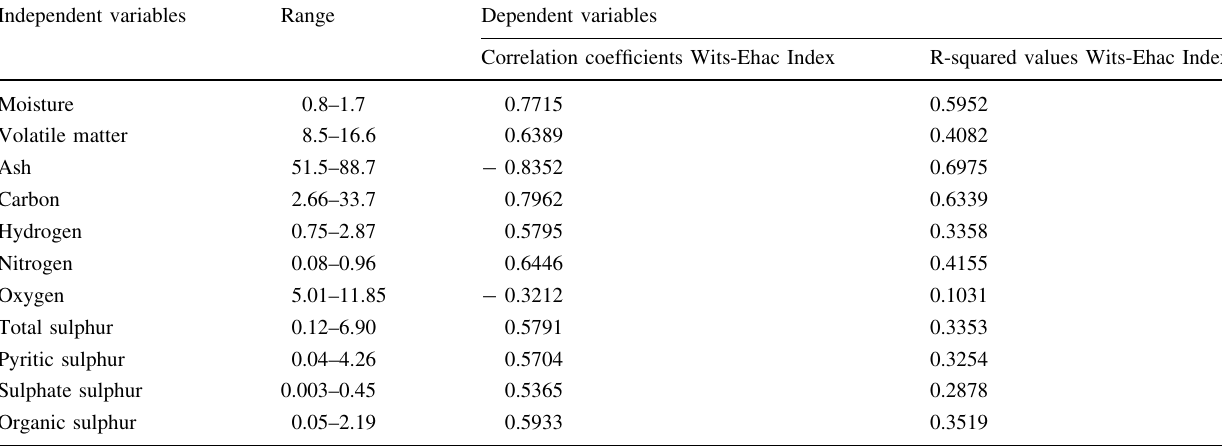
Table 5 Relationships between independent (proximate and ultimate analysis, wt%-ad) and dependent variables for the coal-shale samples